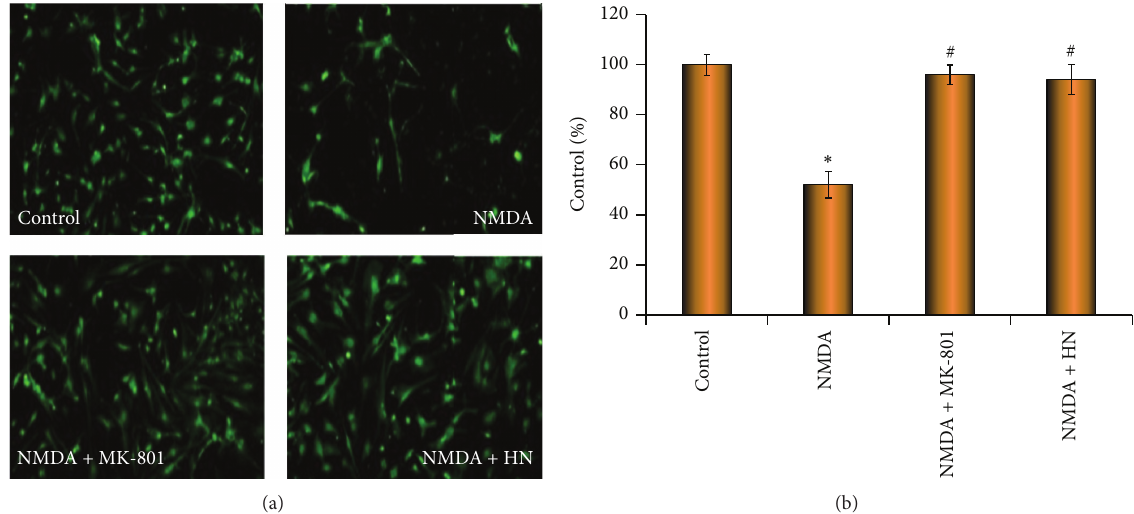
Figure 2: Effect of humanin on density of living neurons under the challenge of NMDA. Representative cellular density of each group is shown by calcein staining under fluorescence microscope. Each bar represents mean ± SEM of eight independent observations. The date from each observation is expressed as the percentage of fluorescent cells in each group compared with control (100%). Statistical significance is at 𝑃 < 0.05 . 𝐹 (3,116) = 4.826 and 𝑃 = 0.003 according to one-way ANOVA analysis. ∗ represents control versus NMDA group, 𝑃 = 0.012 ; # represents NMDA group versus NMDA + MK-801 group ( 𝑃 = 0.026 ) or NMDA + HN (Humanin) group ( 𝑃 = 0.009 ). ∗ and # mean the existence of statistical significance